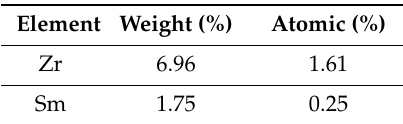
Table 3. Quantitative EDS analysis results obtained from point 1 on the surface of the sample presented in Figure 7 (data only for Zr and Sm).